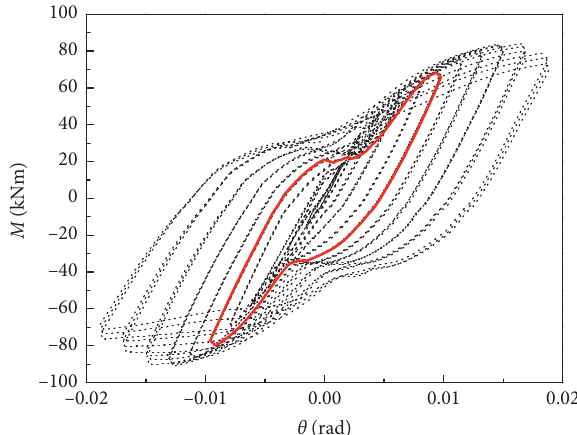
Figure 11: Hysteresis loops of the